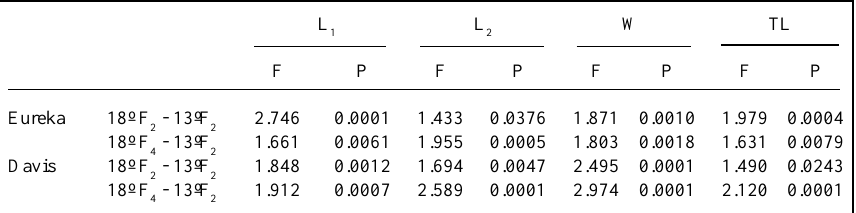
Table III - Results of F-test for the comparisons of variances between 18ºC (F Drosophila subobscura females in both populations (Davis and